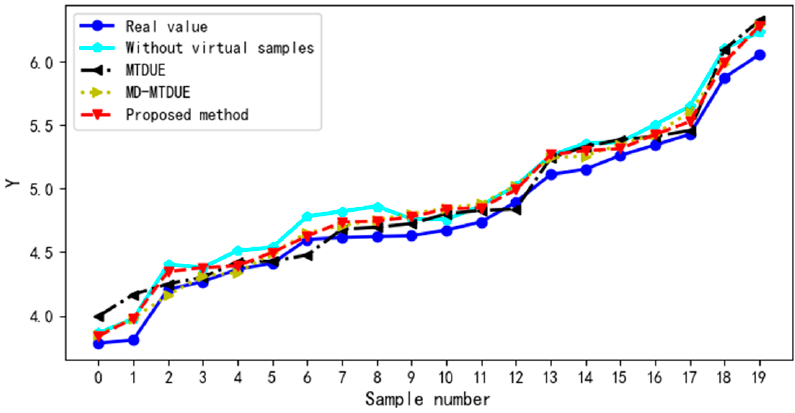
Figure 5. Distribution curve of the real and predicted test sample values in the model.